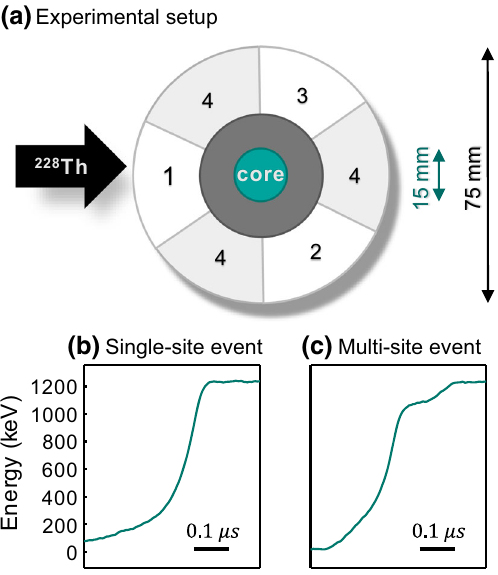
Fig. 1 a Schematic of the top of the segmented BEGe detector with the n + electrode (core) and the 4 segments. The ring around the core is passivated. The diameters of the detector and the core contact are 75 mm and 15 mm, respectively. Also shown is the azimuthal position of the 228 Th source. b , c The rising part of the charge waveforms recorded by the core electrode from a typical SS and a MS event, both with an energy of 1242